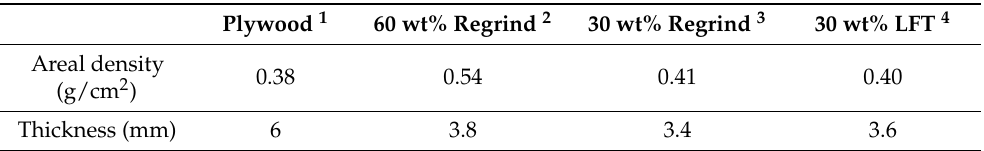
Table 5. Comparison of materials for use for trailer applications. Compares density and thickness of plywood to reprocessed PP-GF scrap and standard